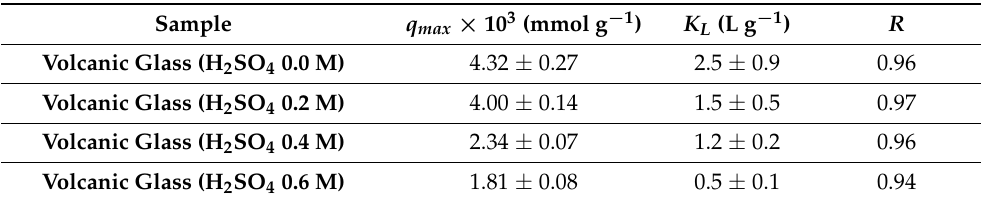
Table 3. Equilibrium adsorption parameters according to the Langmuir model to Cu 2+ adsorption on volcanic